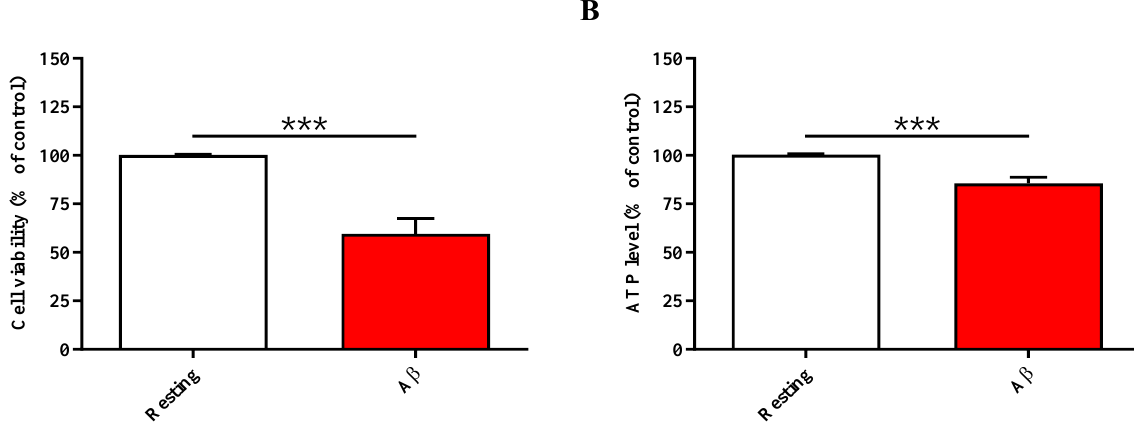
Figure 1. Change in ( A ) cell viability and ( B ) ATP intracellular levels caused by challenging ARPE-19 cells with A β 1-42 oligomers. ARPE-19 cells were treated for 48 h with A β 1-42 oligomers (2 µ M). Data are the mean of four to seven values and are expressed as the percent variation with respect to the cell viability or ATP levels recorded in resting (control) cells. Standard deviations are represented by vertical bars. *** significantly different, p < 0.001.